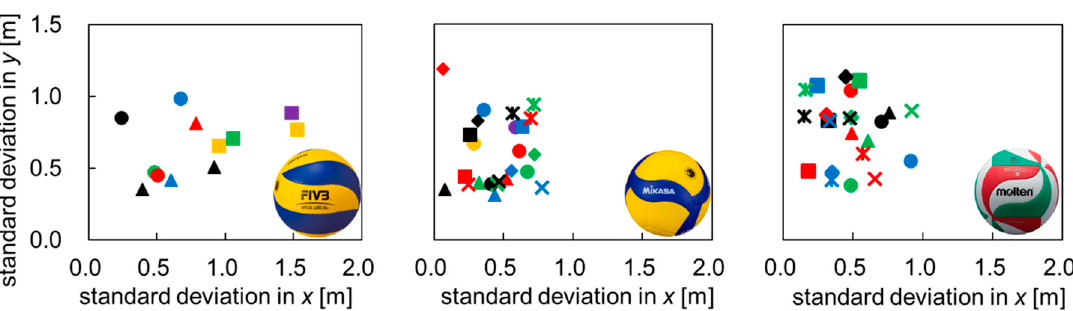
Figure 10. Standard deviation of the drop position by the panel in the x and y directions.